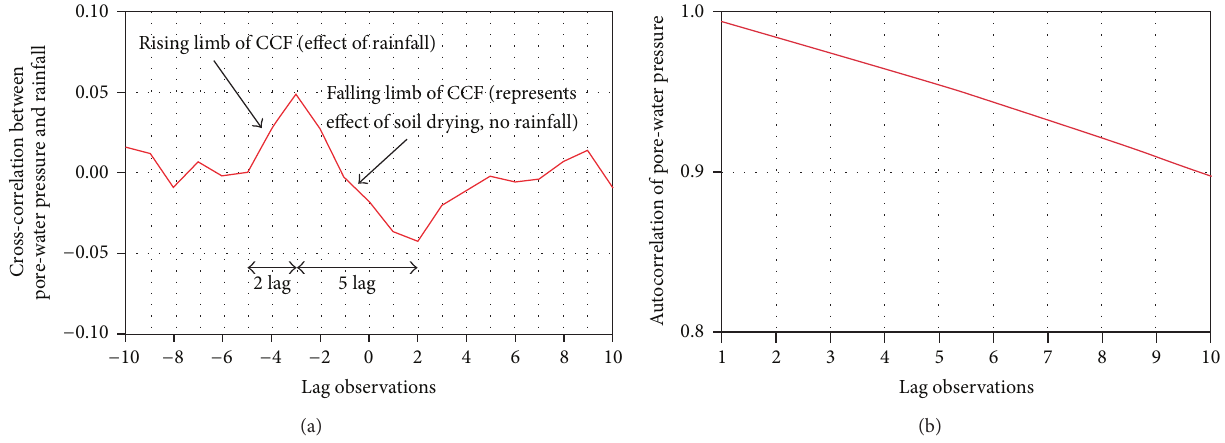
Figure 4: (a) Cross-correlation between pore-water pressure and rainfall. (b) Autocorrelation of pore-water pressures.